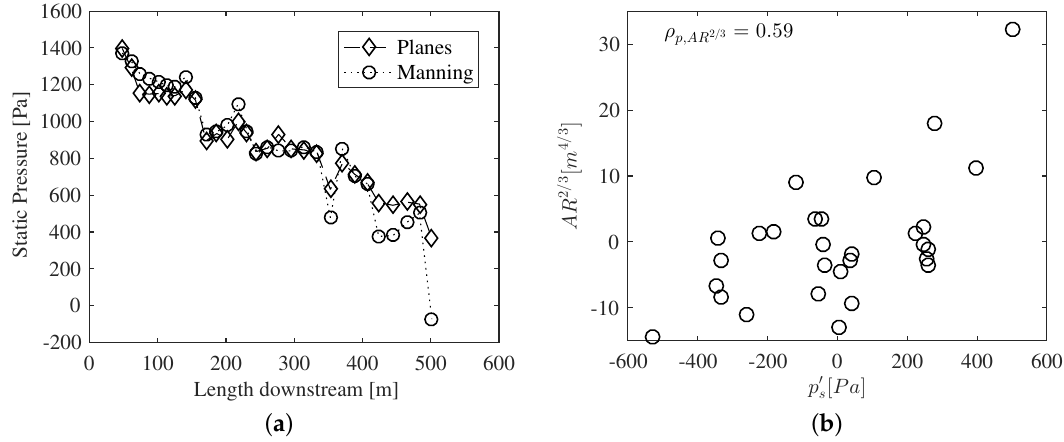
Figure 5. ( a ) The circles represent accumulated head loss estimated using Equation (4) and the diamonds are from Figure 4. ( b ) The static pressure as a function of hydraulic radius, ρ p , AR 2/3 represents the Pearson correlation